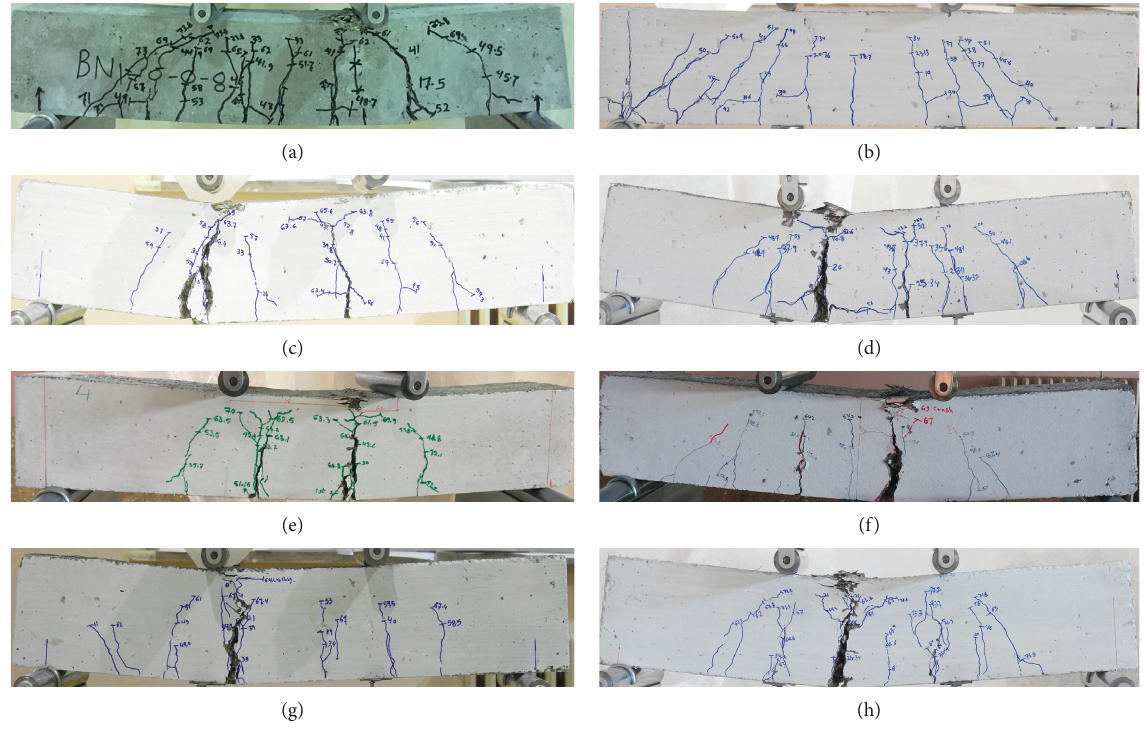
Figure 10: Final crackingpatterns of the tested beams after failure: (a) S-0, (b)H-0, (c) S-0.5,(d) H-0.5, (e)S-1.0, (f) H-1.0,(g) S-1.5,and (h) H-1.5.